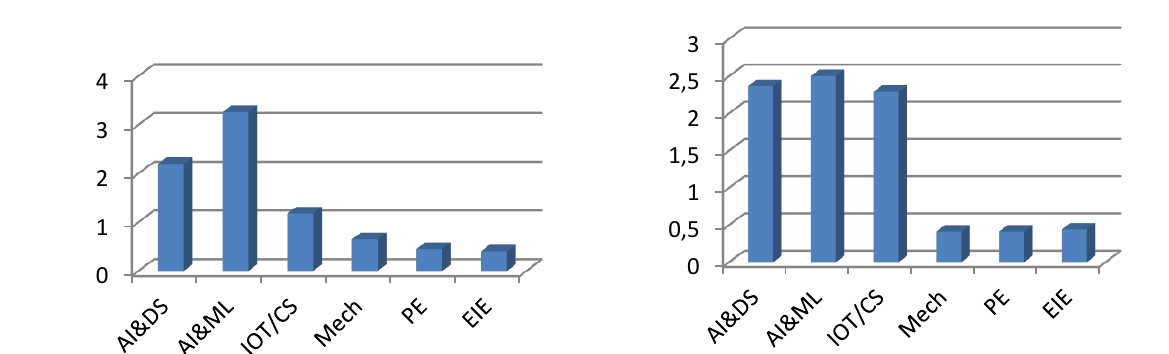
Figure 3: Weights of alternatives with respect to C 3